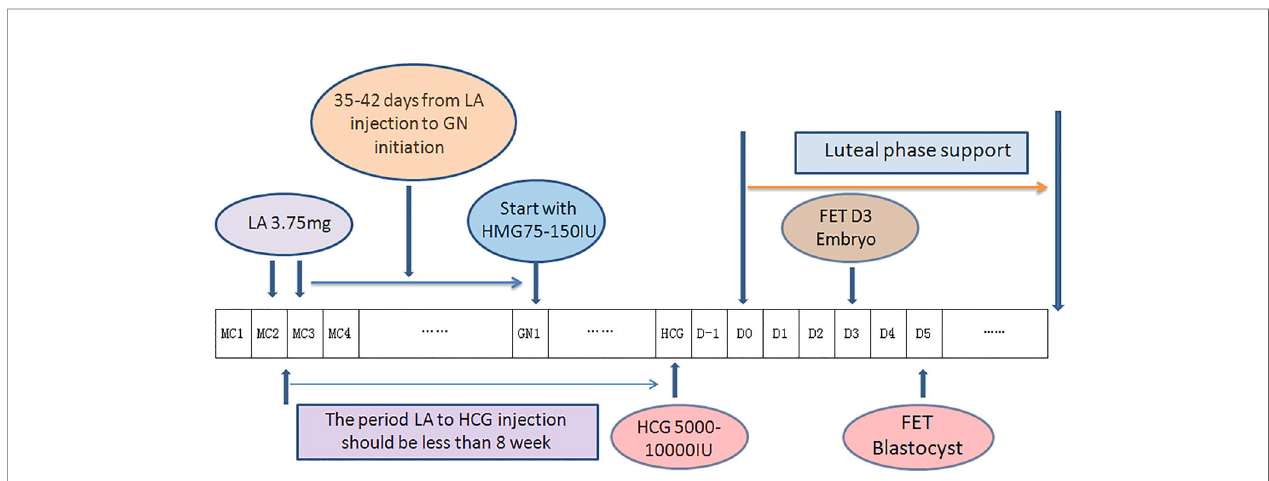
FIGURE 1 | Flow chart of down-regulation ovulation-induction procedure. One depot of 3.75 mg leuprorelin acetate was injected at the 2nd or 3rd day of the menstrual cycle, in which ovarian stimulation with 75 – 150 IU Gns would start 35 – 42 days later along with con fi rmation of pituitary downregulation. Gonadotropin stimulation continued until endometrial thickness ≥ 7 mm. A dose of HCG 5000-1000 IU was injected at 9:00 p.m. and ET was arranged 5 days later for D3 embryos or 7 days later for blastocysts. Progesterone supplement was initiated 2 days after ovulatory trigger as fresh ET. (LA, leuprorelin acetate; GN, Gonadotropin; HCG, Human Chorionic Gonadotropin; MC, Mnstrual Cycle; D0, theoretical oocyte retrieval